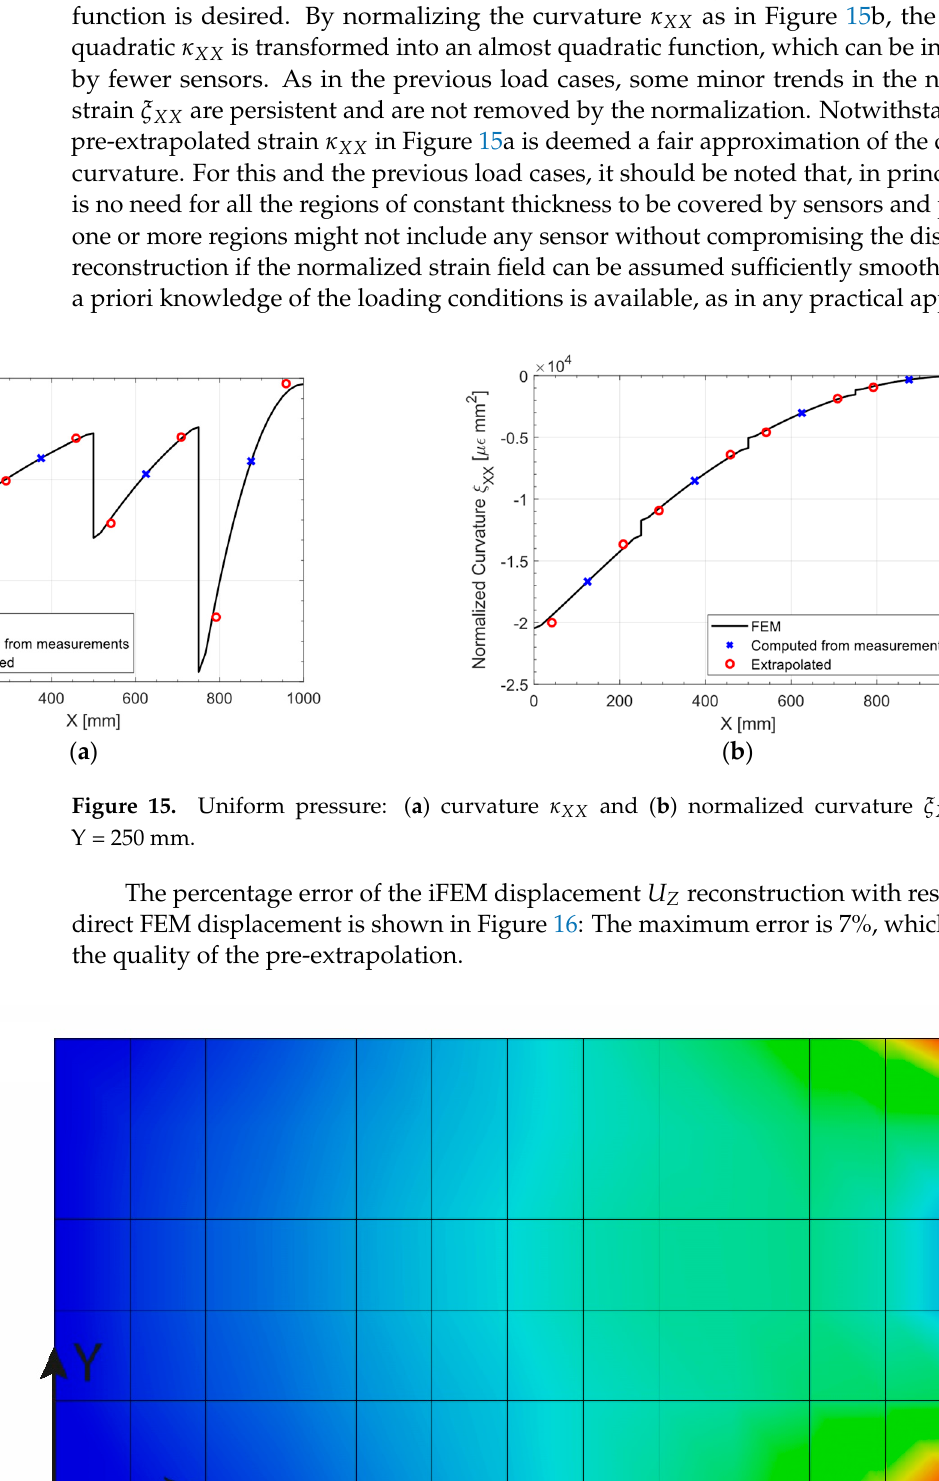
Figure 16 . Uniform pressure: percentage error of the 𝑈 (cid:3027) displacement.